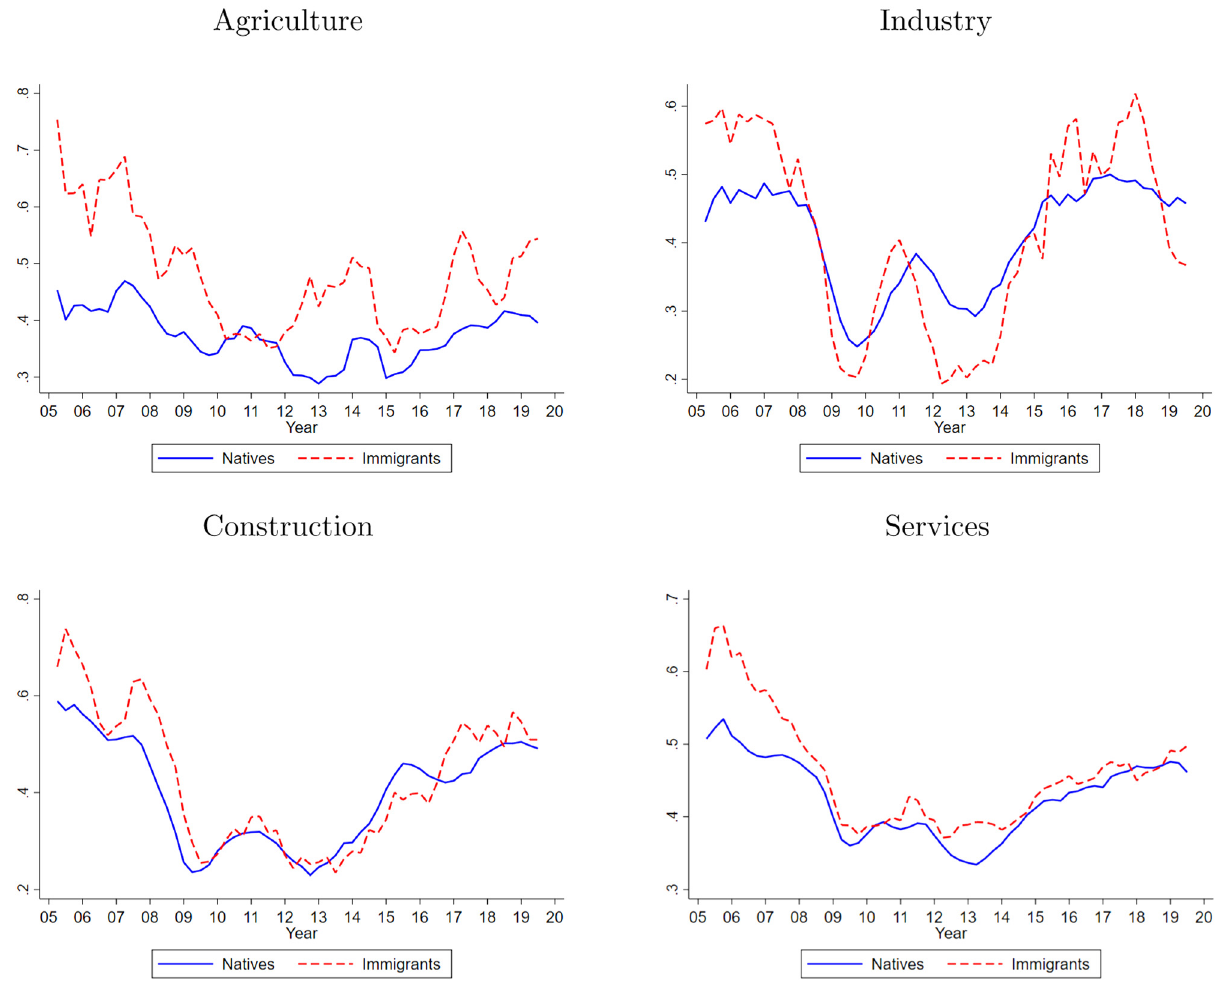
Figure A5: Job - fi nding rate by nationality and sector. Note: The transitions are seasonally adjusted using a 4 - quarters moving average, constructed from the Spanish Labour Force Survey -